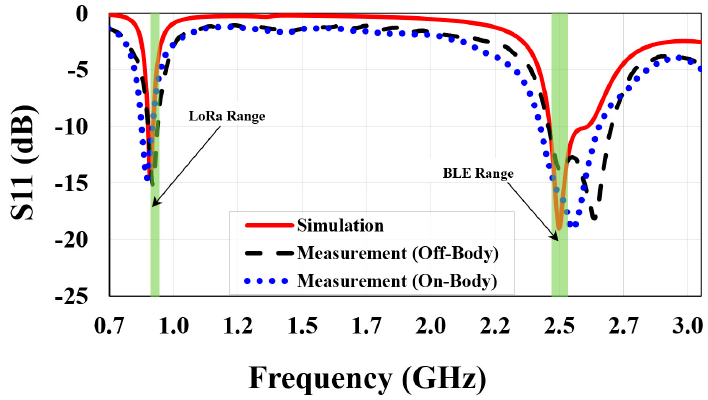
Figure 6. Measured antenna’s S11 compared to the simulated result.